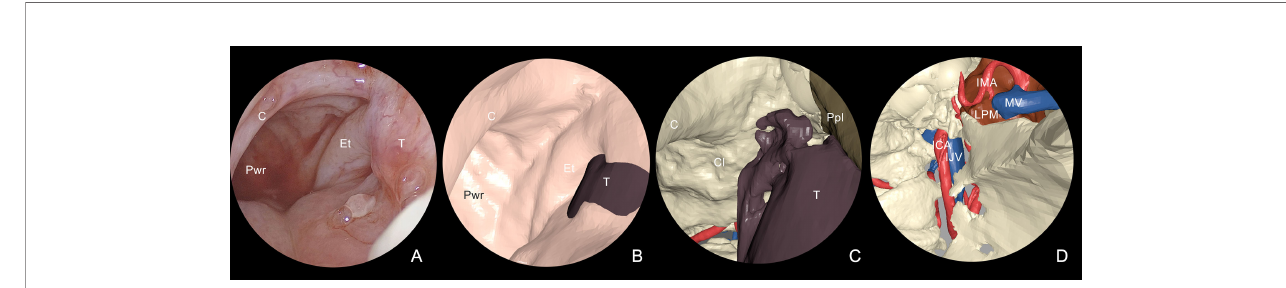
FIGURE 4 | Multilayer anatomical reconstruction applied to endoscopic view. (A) Overview of real endoscopic scenario; (B) virtual endoscopy shows the mucosal lining and the tumor bulging around the tubaric ori fi ce area; (C) selective hiding of the mucosa reveals the underlying tumor in relation with skeletal structures and underlying vessels; (D) tumor hiding reveals the proximity with dangerous structures, including IMA and ICA. T, tumor; Et, eustachian tube; C, choana; Pwr, posterior wall of the rhinopharynx; Cl, clivus; Ppl, pterygoid plate; LPM, lateral pterygoid muscle; IMA, internal maxillary artery; ICA, internal carotid artery; MV, maxillary vein; IJV, internal jugular vein.